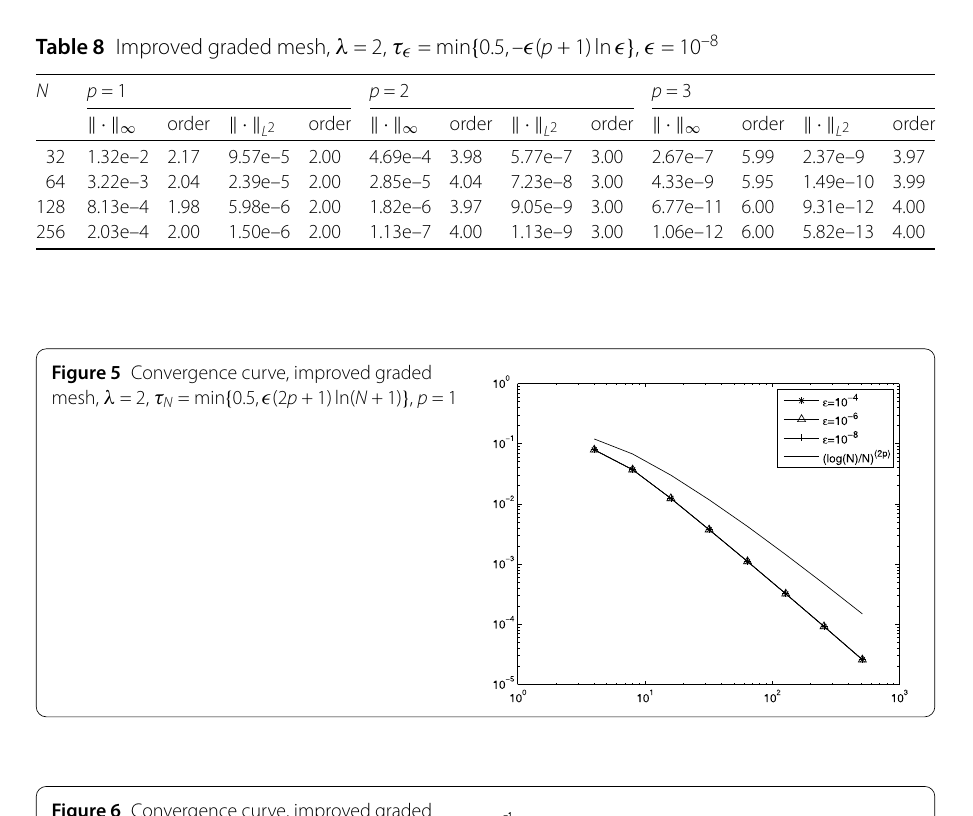
Figure 6 Convergence curve, improved graded mesh, λ = 2, τ N = min { 0.5, (cid:2) (2 p + 1)ln( N + 1) } , p = 2